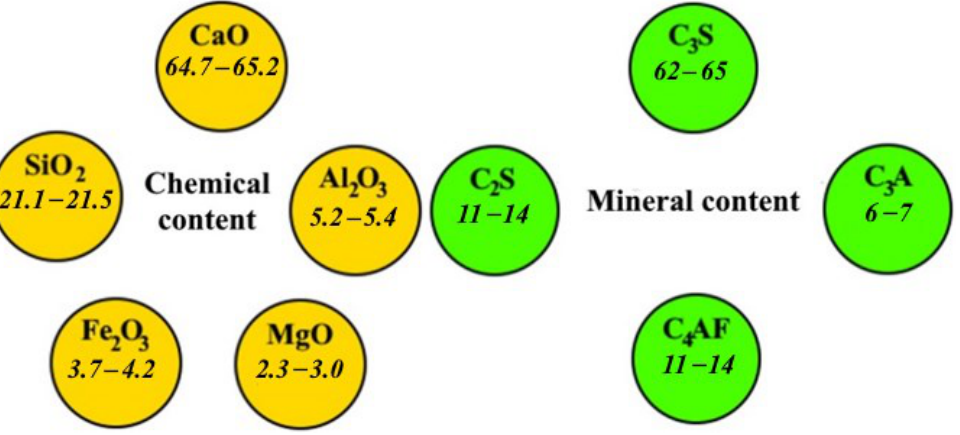
Figure 5. Chemical and mineral composition of the Portland cement, wt. %.